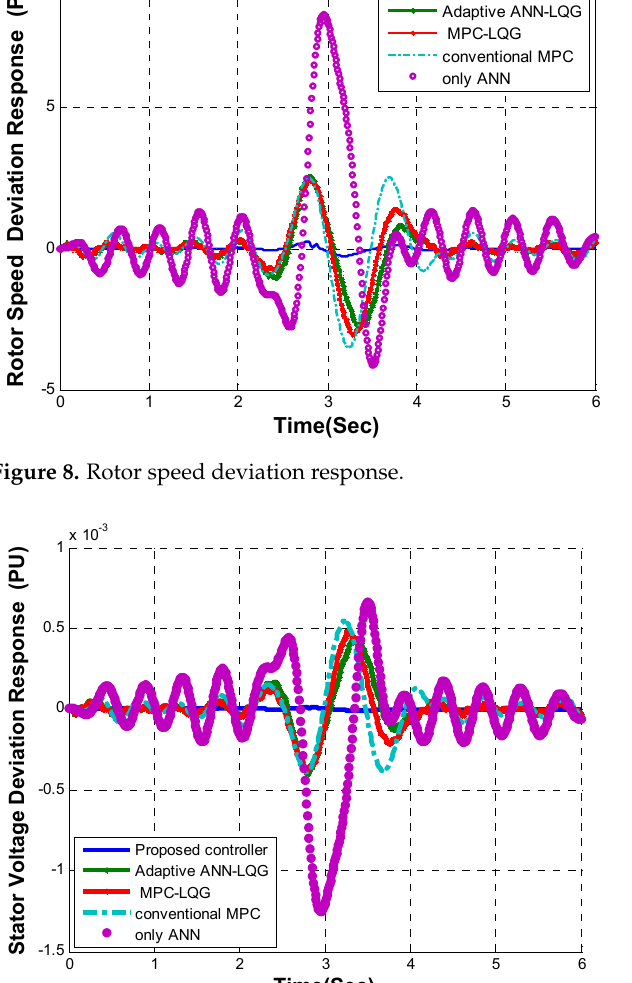
Figure 9. Stator voltage deviation response.